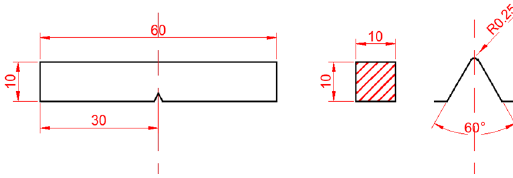
Figure 1. Dimensions of impact specimens (in mm).